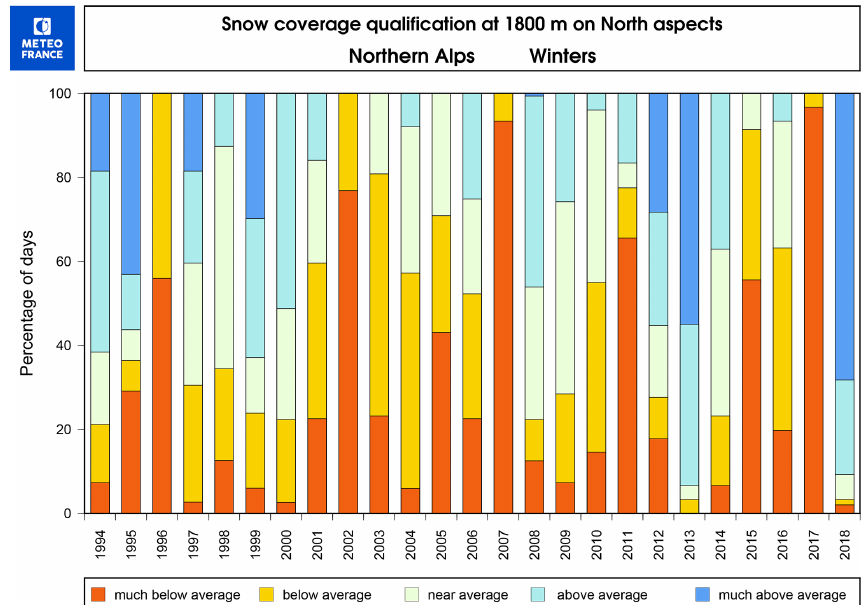
Figure 8. Qualification of snow coverage at 1800m on northern aspects in the French northern Alps: for each winter (November–April), percentage of days with total snow depth much below average (lower than the 20th climatological percentile), below average (between the 20th and 40th percentiles), near average (between the 40th and 60th percentiles), above average (between the 60th and 80th percentiles), and much above average (higher than the 80th climatological percentile).